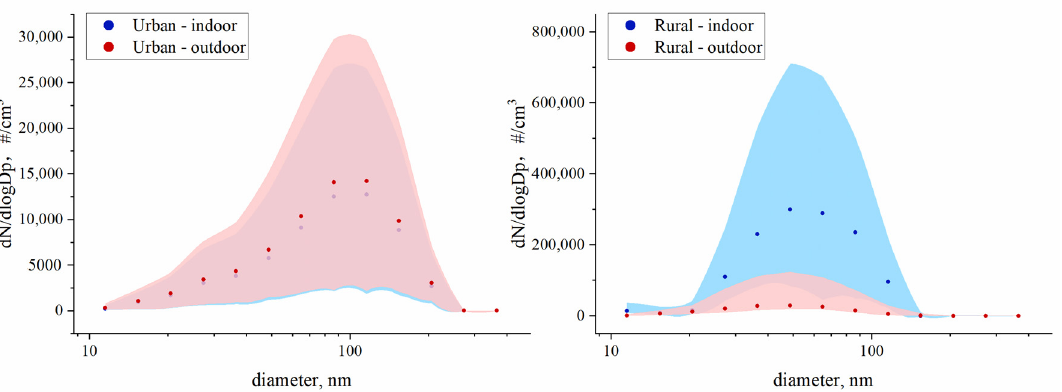
Figure 2. Size distributions of UFPs in indoor and outdoor air from the urban household without indoor combustion sources ( left ) and the rural room burning coals ( right ). Dp means particle diam ‐ eter.